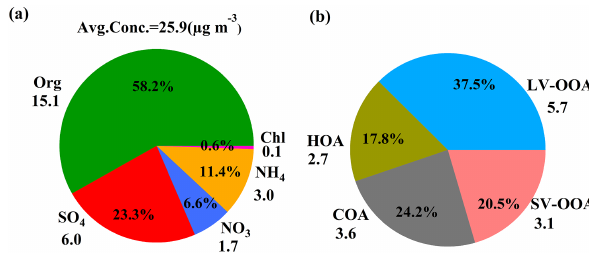
Figure 2. Average concentration of each chemical composition of (a) NR-PM 1 (Org, SO 4 , NO 3 , NH 4 and Chl) and (b) organic aerosol (LV-OOA, SV-OOA, HOA and